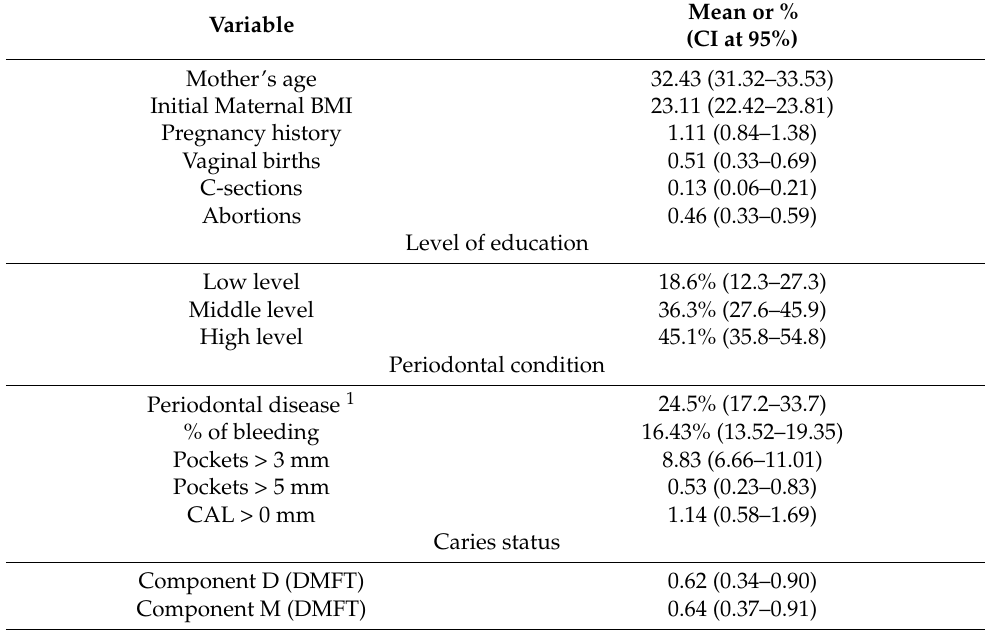
Table 1. Characteristics of the sample.